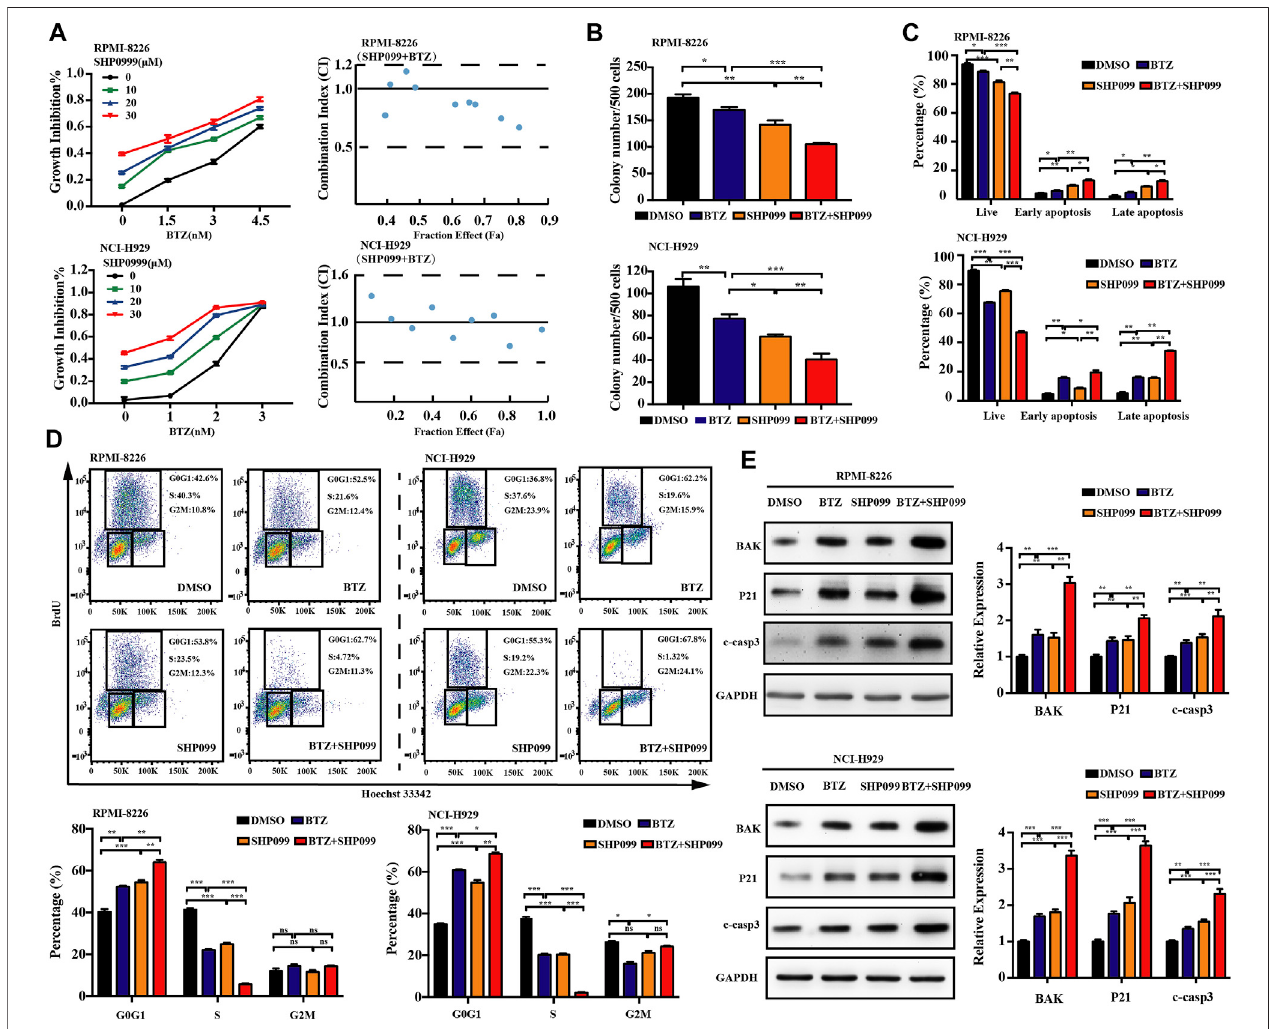
FIGURE 6 | Co-treatment of SHP099 and BTZ is synergistically cytotoxic to BTZ-sensitive MM cells. (A) Effect of treatment with different concentrations of BTZ alone or in combination with different doses of SHP099 for 48 h on cell viability of two MM cell lines, RPMI-8226 and NCI-H929, was measured using CCK-8 assay. Combinationindex(CI)fortwodrugsintheMM celllineswasshown.x-axis,fractionaleffectconcentrations;y-axis,CI.RPMI-8226andNCI-H929cellsweretreatedwith DMSO, SHP099 (20 μ M), BTZ (3 nM for RPMI-8226 and 2 nM for NCI-H929 cells respectively), or SHP099 plus BTZ for 48 h, and then colony formation (B) , cell apoptosis (C), andcellcycle (D) weredetected. (E) ImmunoblotanalysisofRPMI-8226andNCI-H929celllinestreatedwithSHP099(20 μ M),BTZ(3 nMforRPMI-8226 and 2 nM for NCI-H929 cells), or SHP099 plus BTZ for 48 h; the relative amount of the protein level, normalized to that of GAPDH expression, was analyzed by ImageJ software. Data were presented as mean ± SD from three independent experiments; * p < 0.05, ** p < 0.01, and *** p < 0.001.